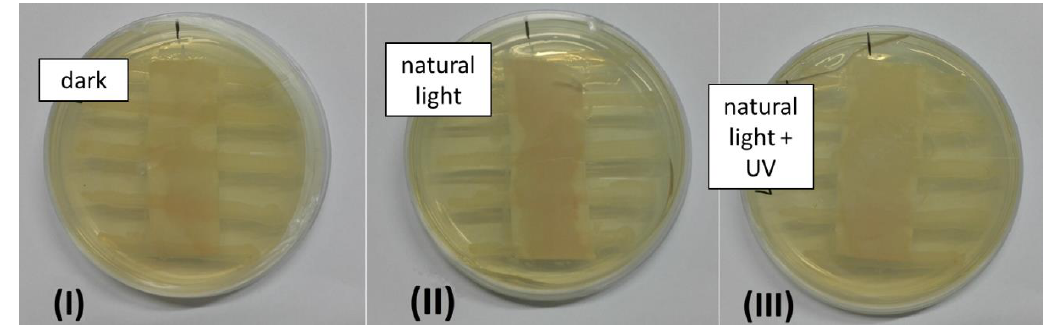
Figure 8. Image of AATCC 147 tests on blue Ir@SiO 2 -coated textiles in the dark ( I ) and under natural light ( II ) and natural light + UV ( III ) conditions.